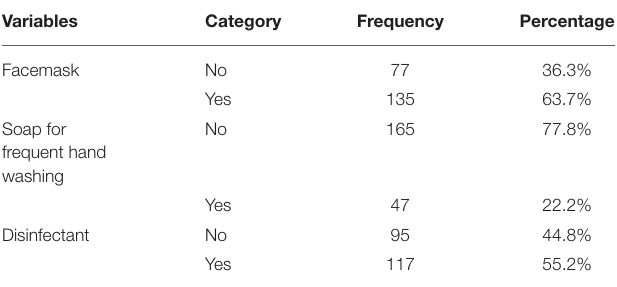
TABLE 4 | Financial burden of the respondents on the COVID-19 preventive measures, Addis Ababa, Ethiopia, May